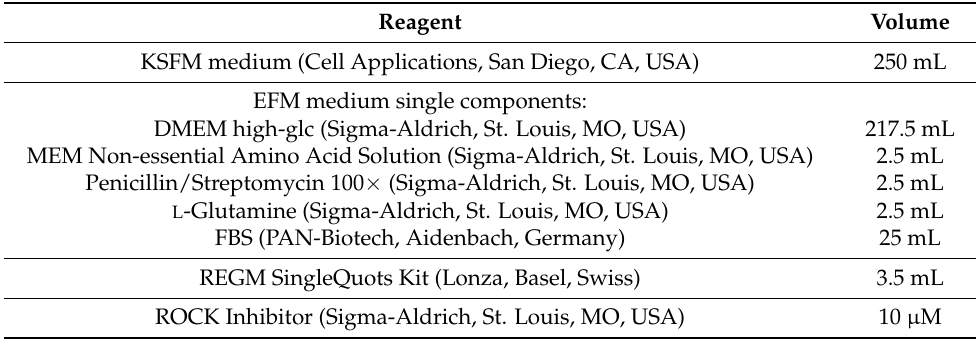
Table 1. Composition and formula of the primary proliferation medium.